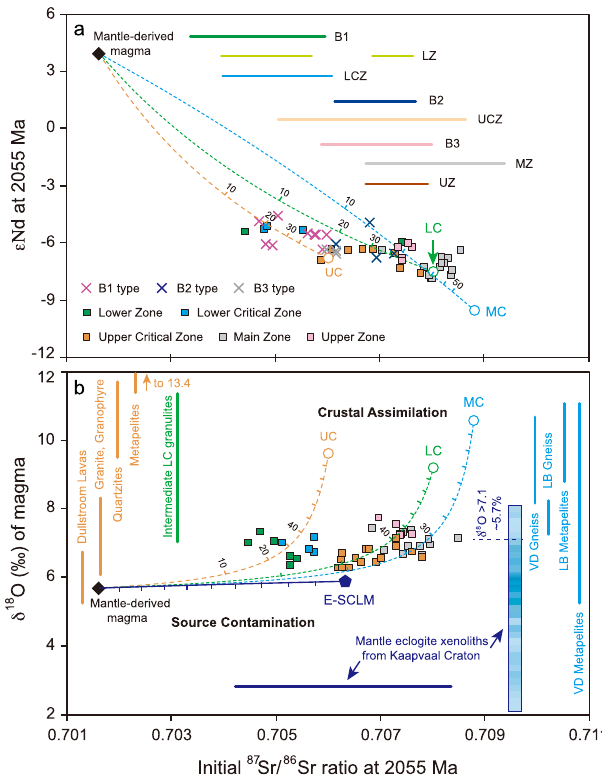
Fig. 6 Isotope correlation diagrams comparing RLS rocks to assimilation models. Curves represent modeled isotopic mixing between primary, mantle-derived magma and different end-members from the Kaapvaal Craton: dashed orange line, upper crust; dashed blue line, middle crust; dashed green line, lower crust; purple line, eclogite-bearing subcontinental lithospheric mantle (E-SCLM). a ε Nd -( 87 Sr/ 86 Sr) i . Horizontal bars in the top-right region exhibit the larger ( 87 Sr/ 86 Sr) i ranges that also include the Sr isotope compositions of samples and minerals without the coupled Nd isotopic data in marginal rocks and cumulate zones of RLS. b δ 18 O-( 87 Sr/ 86 Sr) i . δ 18 O averages with standard deviations of potential assimilants in upper, middle, and lower crusts are shown schematically by vertical orange, blue, and green bars, respectively; averages for various contaminants are shown by circles and pentagram. ( 87 Sr/ 86 Sr) i average plus its standard deviation for eclogite-bearing lithospheric mantle is exhibited by purple horizontal bar, and δ 18 O distribution of mantle eclogite xenoliths from the Kaapvaal Carton is shown by vertical blue color bar with deep tone corresponding to a higher frequency. Garnets with δ 18 O > 7.1 ‰ represent only ~5.7% of the total of 157 available samples from Kaapvaal Craton 60 . All data are collected from multiple sources cited in the Supplementary References. LB Limpopo Belt, VD Vredefort Dome. Source data are provided as a Source Data fi